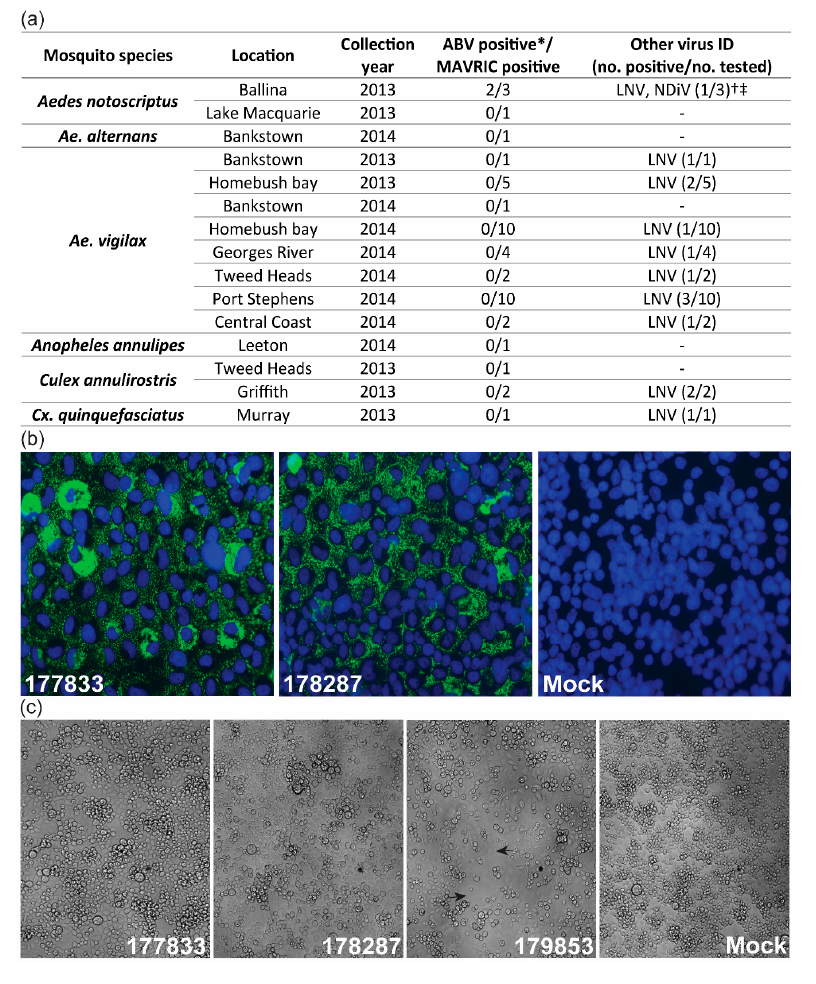
Figure 1. Isolation and prevalence of Aedes birnavirus (ABV). ( a ) Summary of screening for ABV and known insect-specific viruses (ISVs) in MAVRIC-positive mosquito pools collected in NSW between 2013 and 2014. ( b ) Anti-double-stranded RNA (dsRNA) immunolabeling in C6 / 36 cells inoculated with mosquito pools 177833 and 178287, or mock infected (media only) in immunofluorescence assay. Images were taken at 63 × magnification. Green: dsRNA. Blue: nuclei. ( c ) C6 / 36 cells infected with ABV isolates 177833 and 178287, NDiV / LNV co-infected isolate 179853 and mock-infected cells. Gaps in the monolayer typical of NDiV / LNV infection are depicted by arrows for isolate 179853. Cell monolayer images were taken at 20x magnification. * Screened by RT-PCR with ABV-specific primers. The † LNV / NDiV-positive pool did not contain ABV. ‡ Ballina LNV / NDiV isolate originally reported in Prow et al.